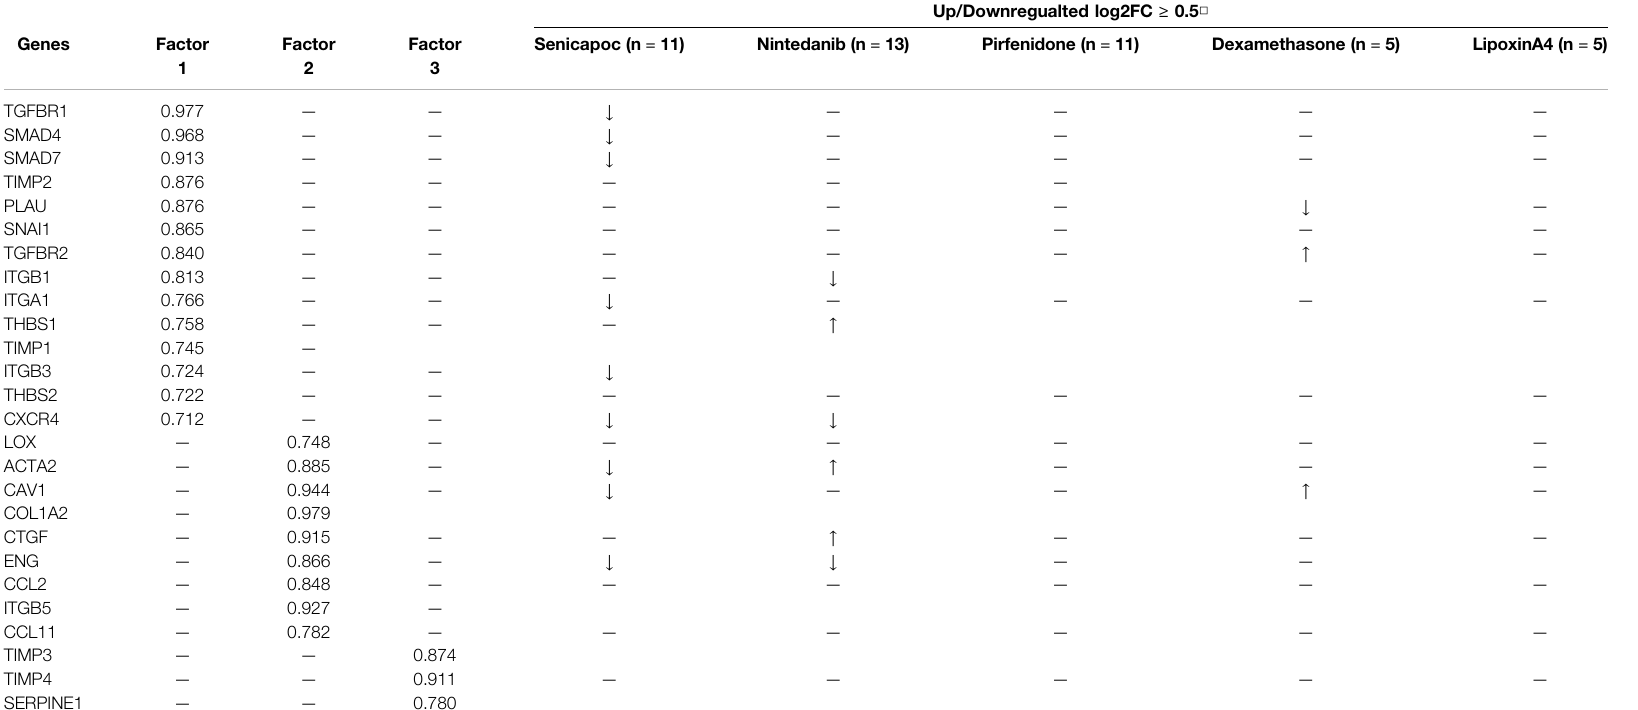
TABLE 1 | Factor analysis of TGF β 1-dependent human lung fi brogenesis, and the effects of drug interventions.